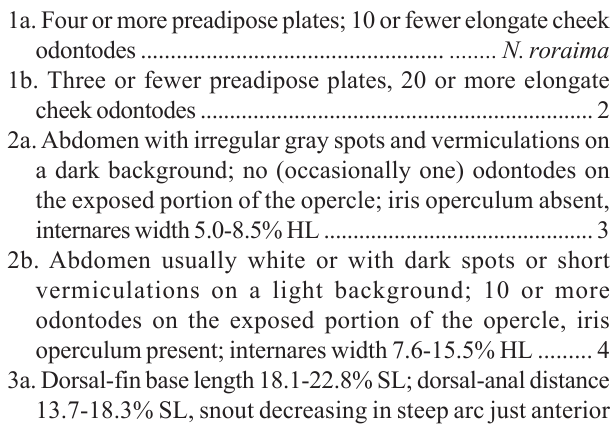
Table 1. Morphometric features of the heads as percentage of HL for Neblinichthys brevibracchium (N = 23, except SL, N = 29), N. echinasus (N = 3), N. pilosus (N = 6), N. roraima (N = 4), and N. yaravi (N = 8, except anal-fin spine L. and interorbital W., N = 7). Landmarks are the numbered landmarks in Armbruster (2003). Some N. roraima have completely adnate barbels, giving a measurement of zero. Revised from Taphorn et al . (2010) where these measurements were inadvertently published as ratios of predorsal length.